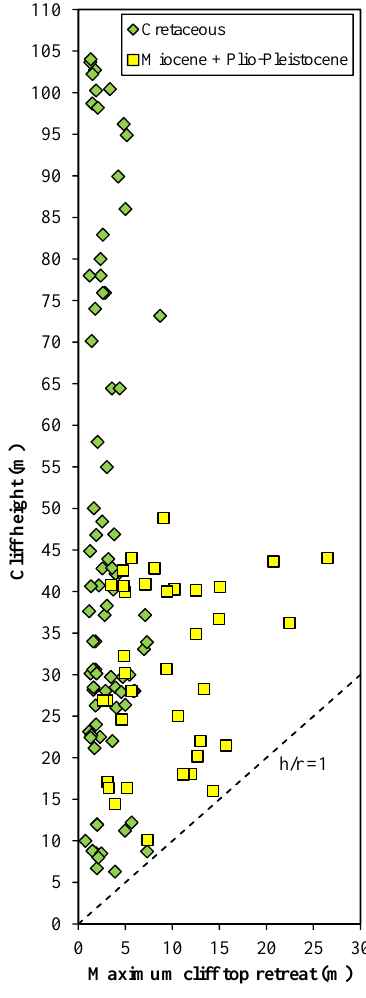
Fig. 4. Variation of maximum cliff top retreat caused by cliff failures Figure 4. Variation of maximum cliff top retreat caused by cliff failures in Cretaceous and 2 in Cretaceous and Miocene plus Plio-Pleistocene formations against Miocene plus Plio-Pleistocene formations against cliff height. Dashed line corresponds to cliff 3 cliff height. Dashed line corresponds to cliff height to a maximum retreat ratio of height to maximum retreat ratio of 1. 4